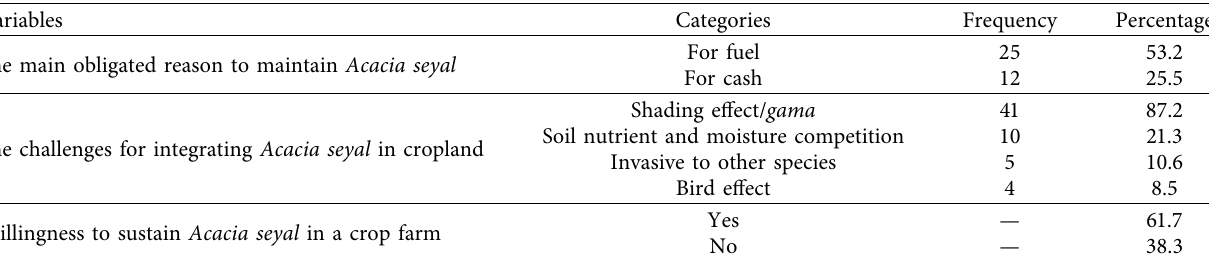
Table 10: Te reason to maintain Acacia seyal , its challenges for integrating on cropland, and farmers’ willingness to sustain. Variables